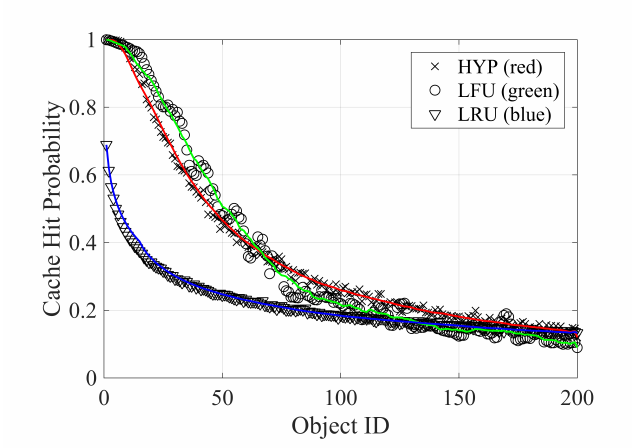
Figure 15. Cache hit probability for the 200 most popular items for a cache close to the